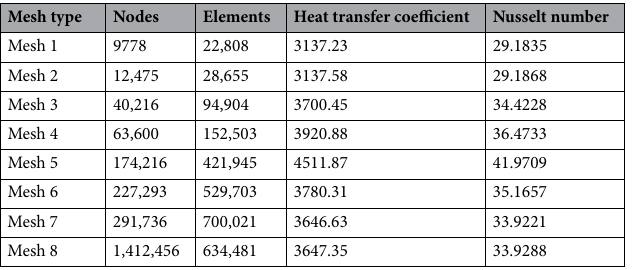
Table 2. Evaluation of Nusselt number and heat transfer coefficient for different grid